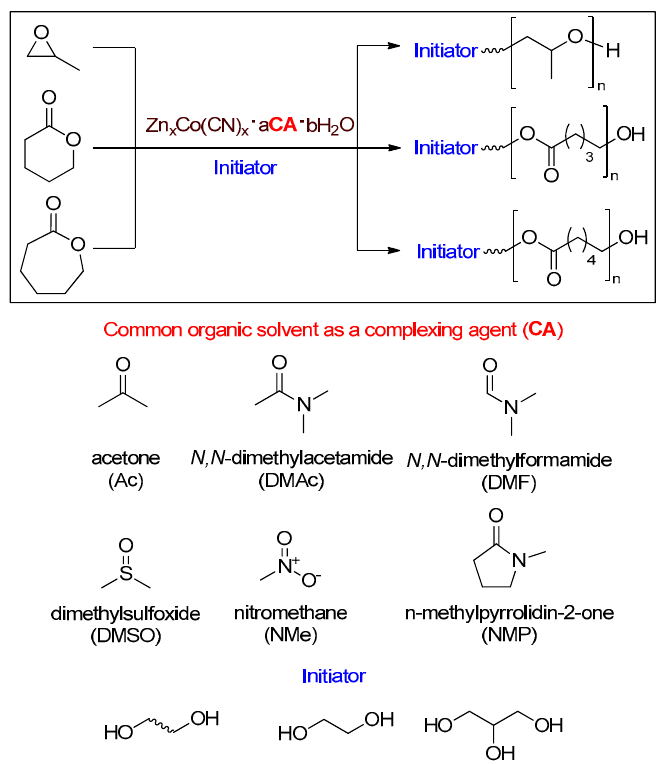
Figure 1. Schematic of the ROP of cyclic monomers using Zn-Co DMC catalysts prepared using various CAs.